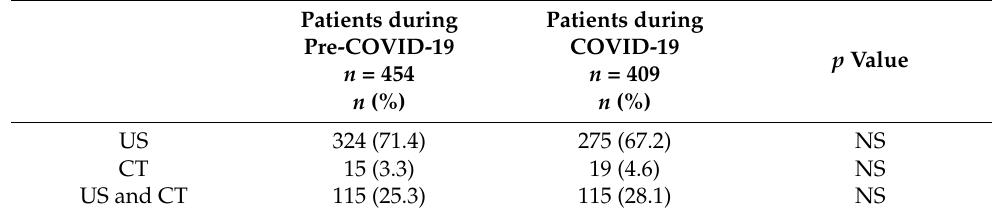
Table 2. Comparison of preoperative diagnostic